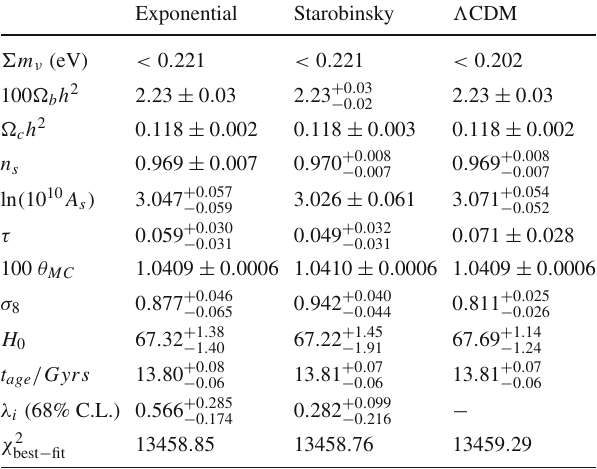
Table 2 Our results within 95% confidence level (C.L.) in the (cid:3) CDM andviable f ( R ) gravitymodels,where λ − 1 the inverses of the model parameters in the exponential and Starobinsky models, respectively